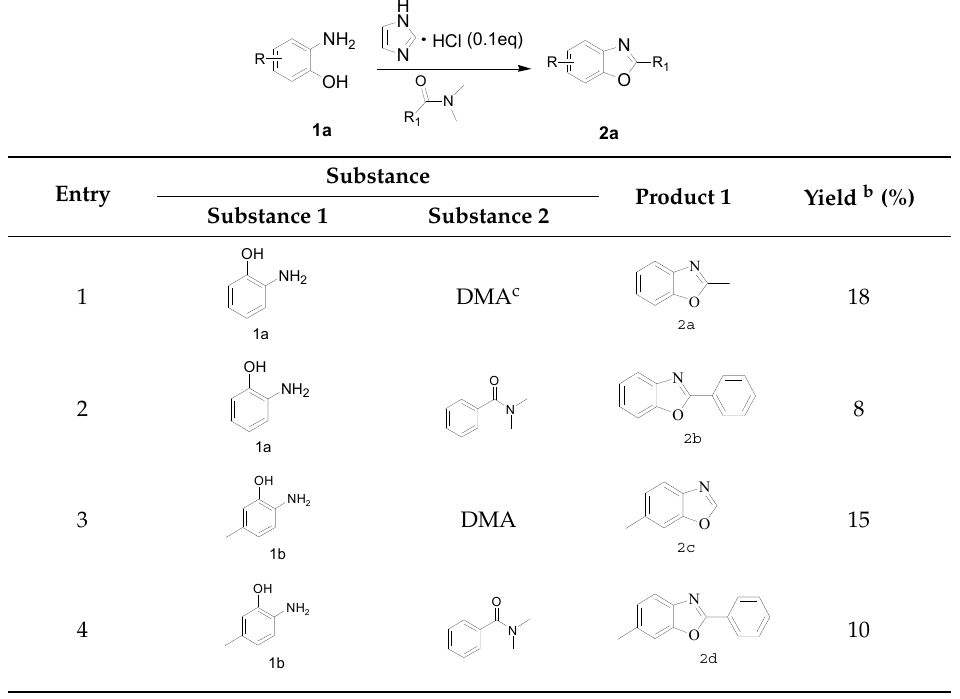
Table 1. synthesis of 2-substituted-benzoxazoles a.